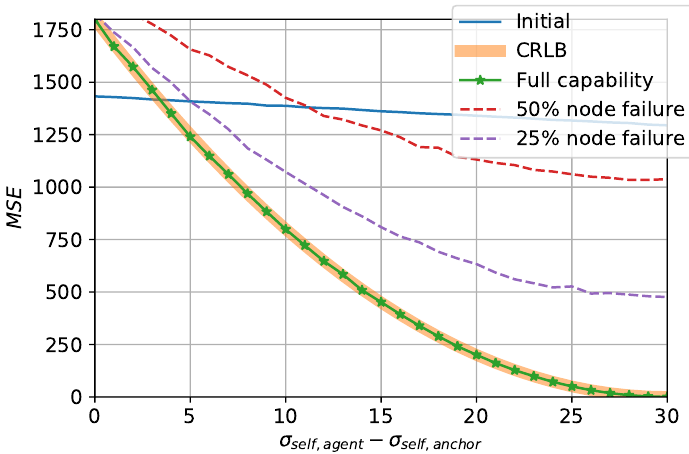
Figure 8. Comparison of Cramér-Rao lower bound (CRLB) and the proposed